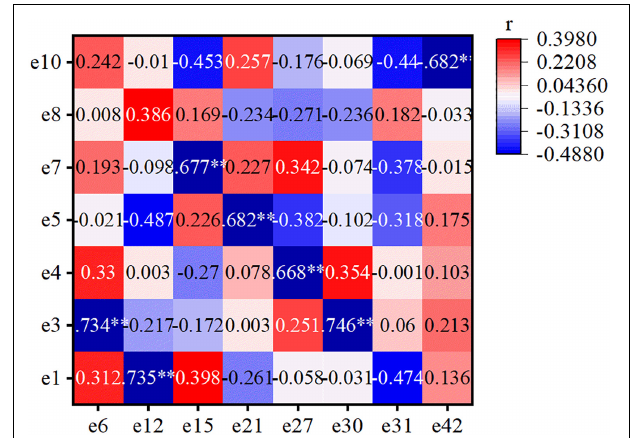
FIGURE 11 | Correlation analysis of the evaluation indicators for the plateau urban national wetland in Huangshui. Population density e1; green coverage rate of the built-up area e3; cumulative area under soil erosion control e4; number of tourists e5; sewage treatment e6; land use intensity e7; sewage discharge e8; ecological environment hydration e10; low temperature e12; wildlife survival rates e15; dissolved oxygen e21; total nitrogen e27; absorb carbon dioxide e30; oxygen release e31; disposition of surrounding population e42.